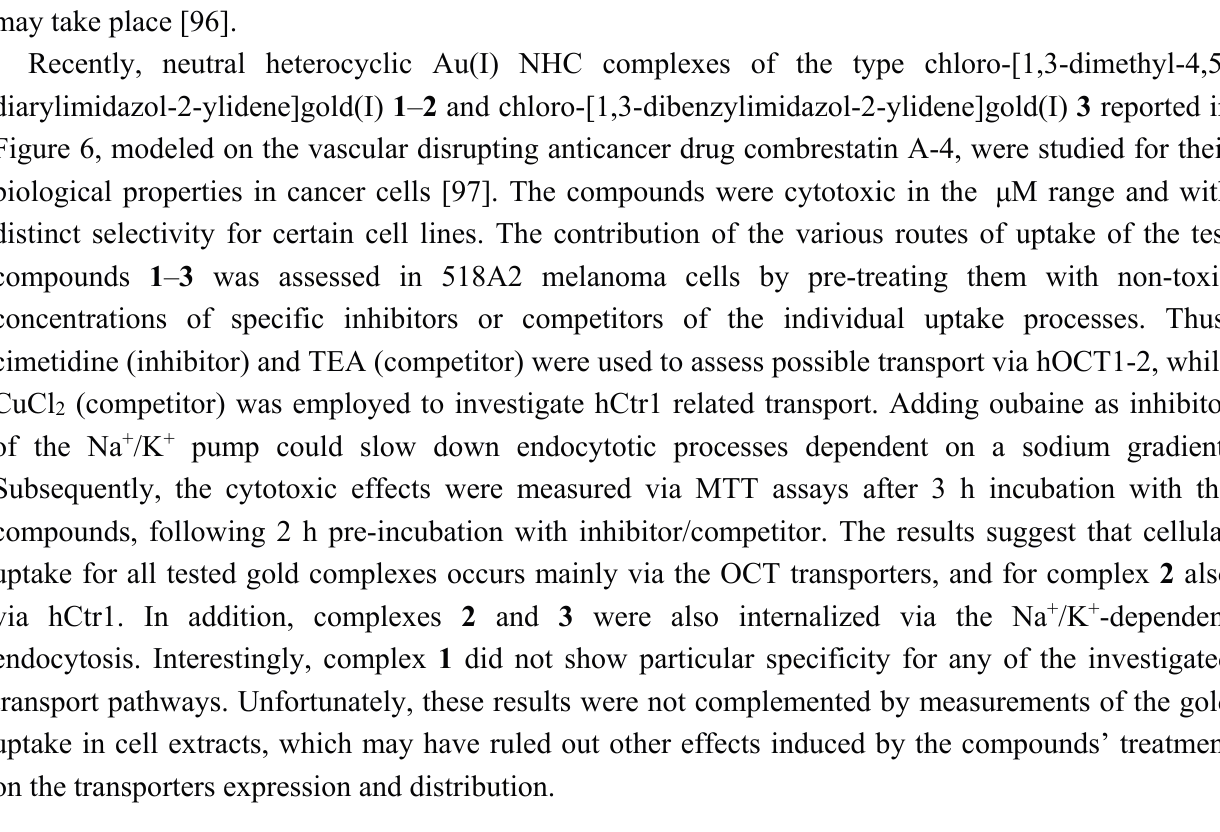
Figure 6. Au(I) NHC complexes